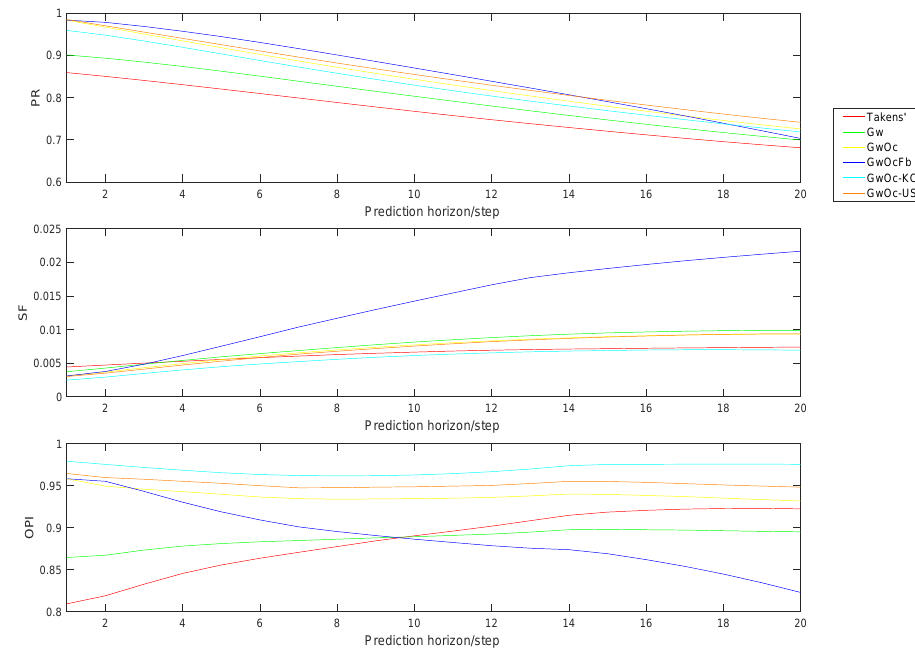
Figure 11. Comparison of prediction performance between the Takens’, Gw, GwOc, GwOcFb, GwOc-KC, and GwOc-US methods (left hip joint data in the sagittal plane). OPI : overall performance index.